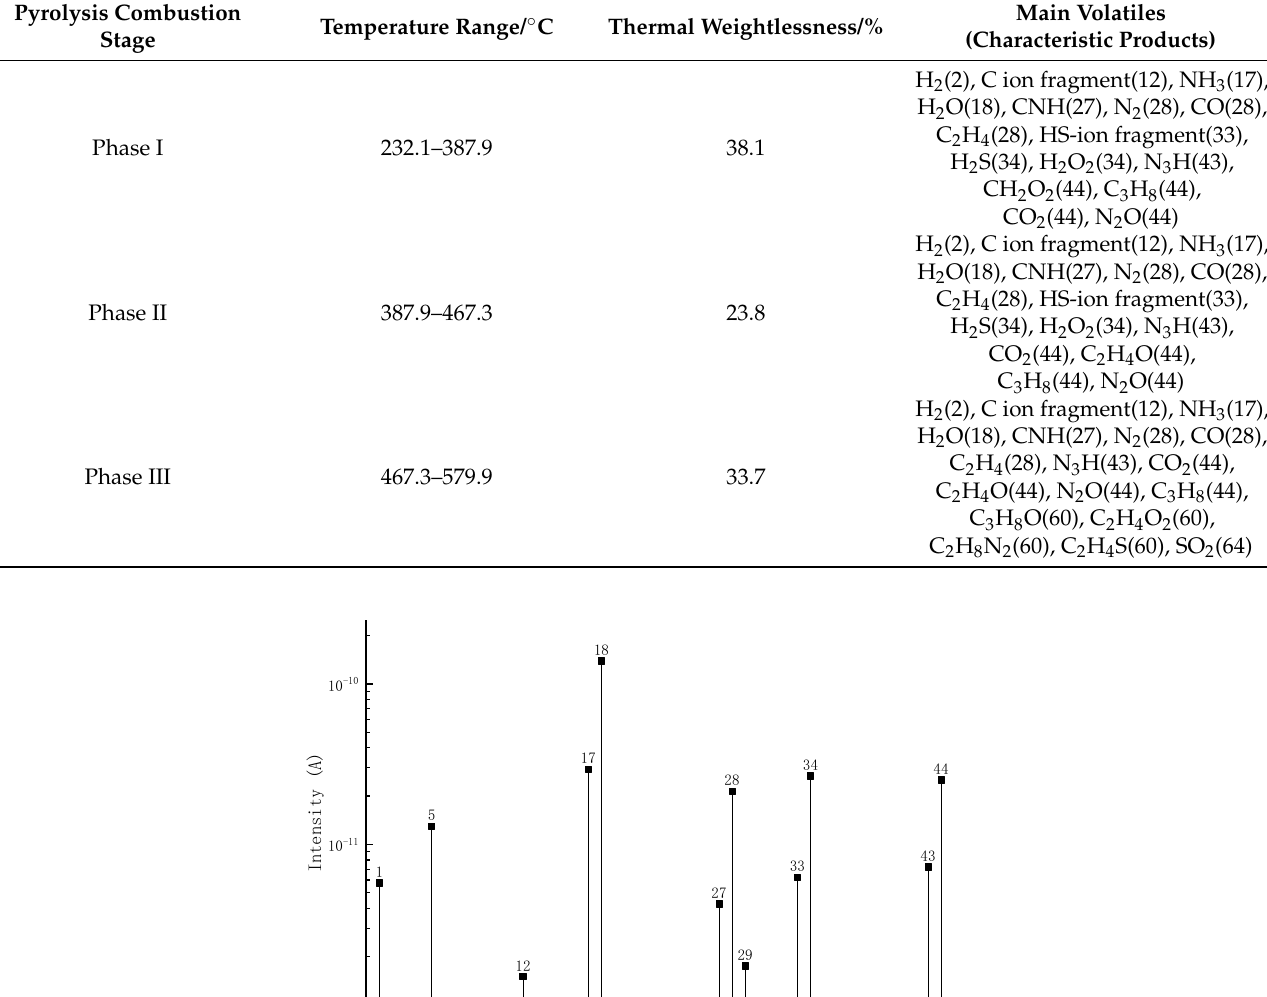
Figure 2. MS-DTG curve of main volatiles from pyrolysis combustion of epoxy asphalt. Table 4. Distribution of volatile matter from pyrolysis combustion of epoxy asphalt.